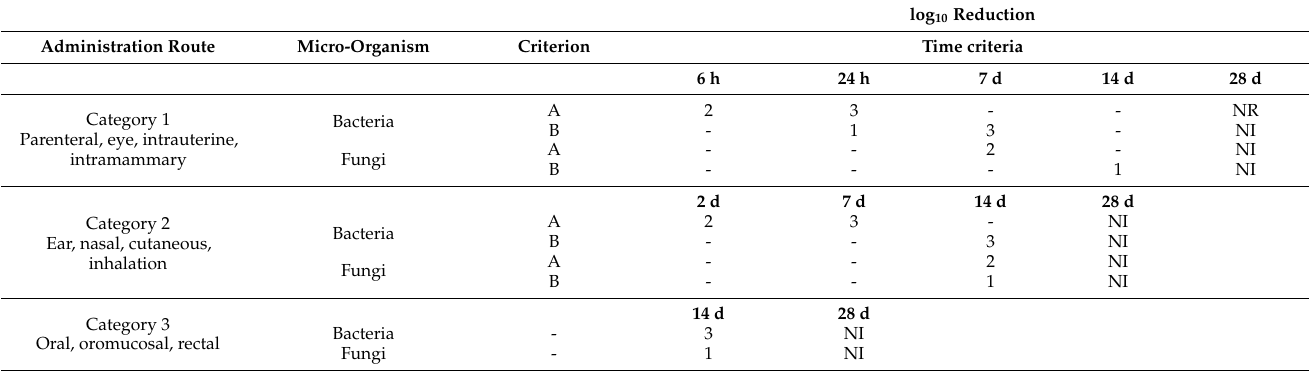
Table 3. Antimicrobial Efficacy Test of the European Pharmacopoeia. The log10 reduction represents the antimicrobial efficacy that must be achieved to meet criteria A and B. The values differ depending on the administration route [10]. log 10